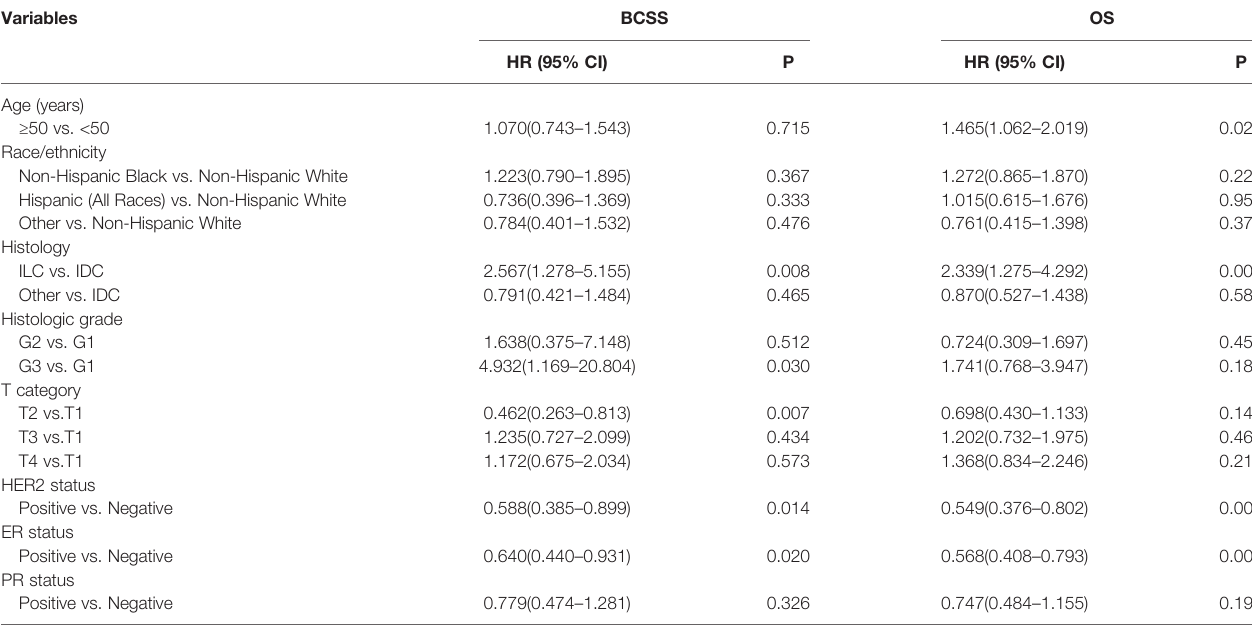
TABLE 3 | Multivariate analysis of prognostic factors using the Cox-regression model (including biologic factors). Variables BCSS OS HR (95% CI) P HR (95% CI)